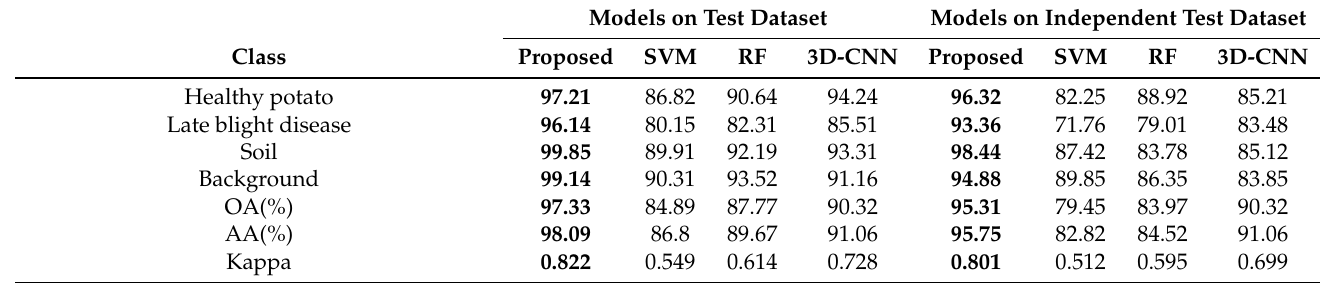
Table 3. The accuracy comparison between the proposed model and existing representative ma- chine/deep learning models in potato late blight disease detection.